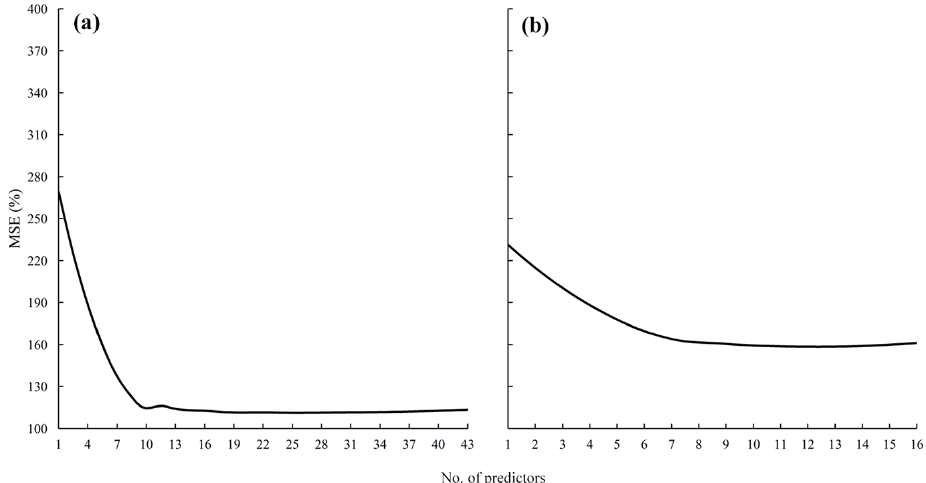
Figure 6. Curves showing the mean squared error (MSE) of the predicted proportion of forest from the random forest ensembles parameter- ized with non-remote-sensing (a) and remote sensing (b) predictors. The number of predictors corresponds to the bar graphs in descending order of